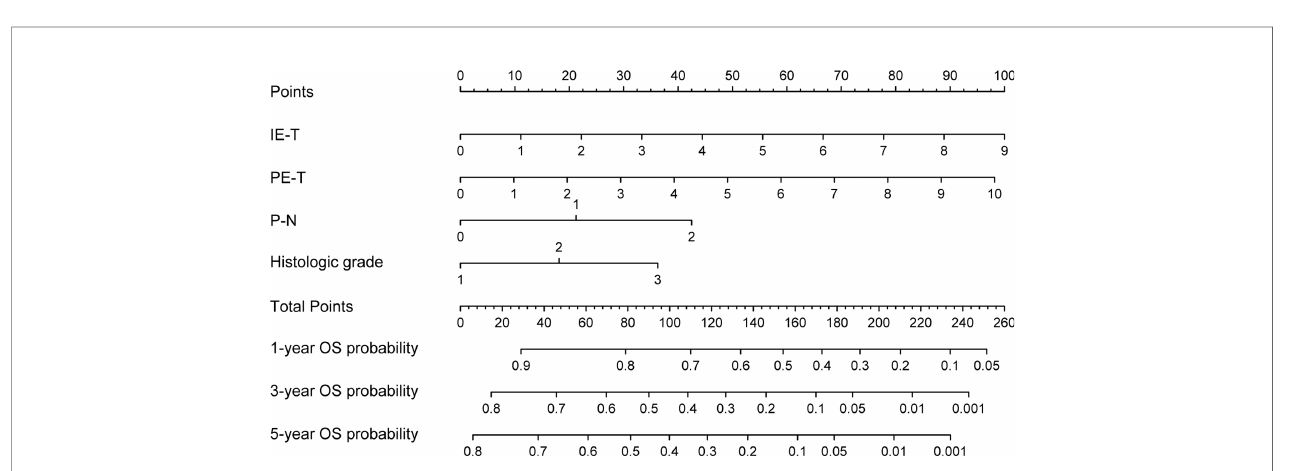
Frontiers in Oncology |